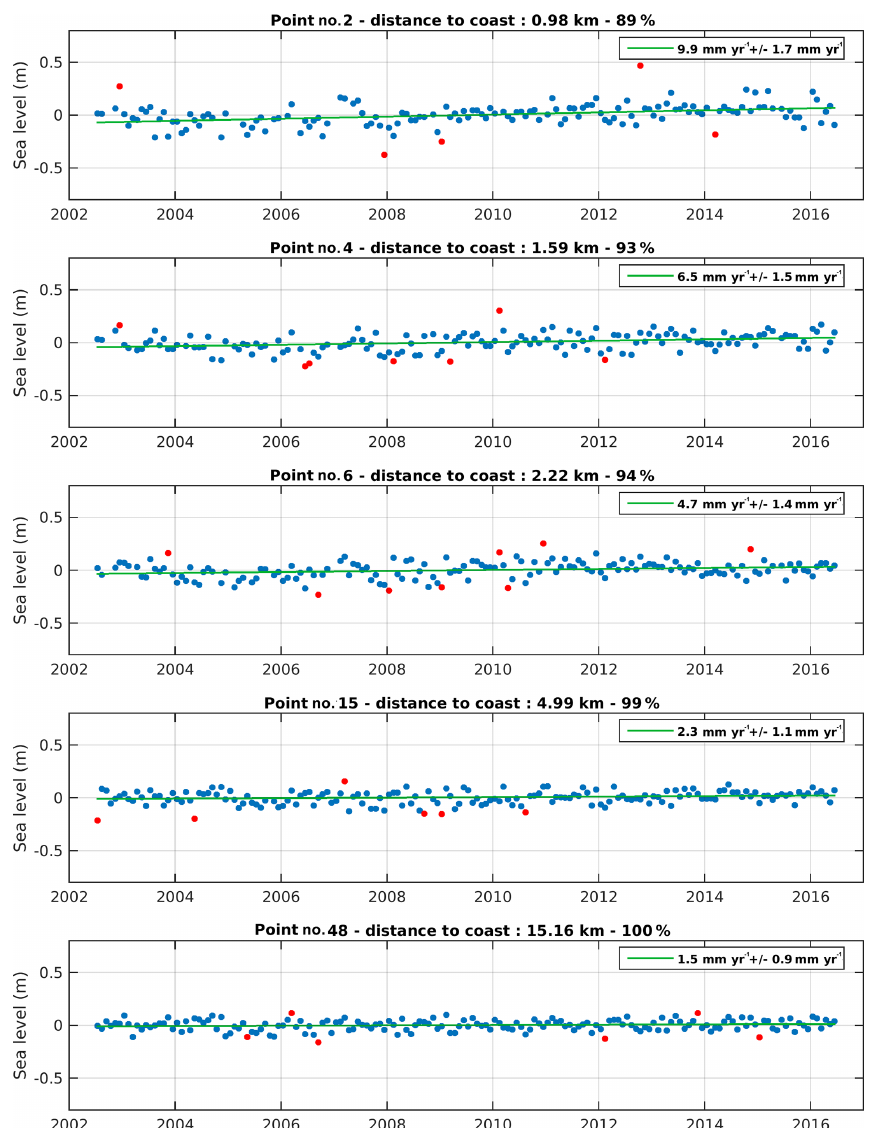
Figure 3. Examples of sea level anomaly time series for 20Hz points located at different distances from the coast. The distance to the coast, percentage of valid data and sea level trends are indicated on each plot. The green curve is the regression line adjusted to the data. The red points on the time series correspond to outliers detected using a simple 2 σ filter (sigma corresponding to the SLA standard deviation). These are not considered to compute the regression